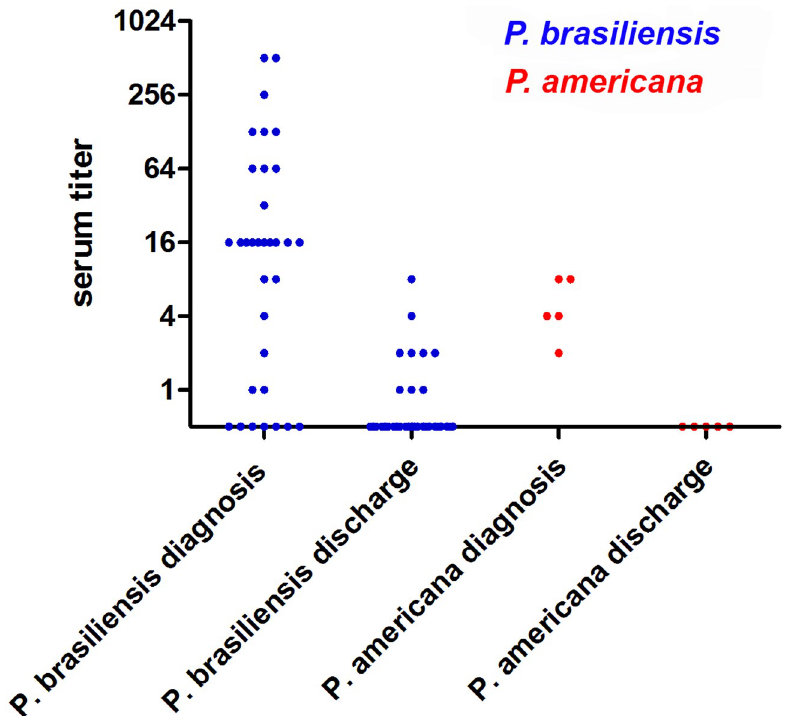
Fig 4. Immunodiffusion reactivity in serological samples from 38 patients of this study. Serum antibody titers from patients infected with P . brasiliensis (blue dots) and P . americana (red dots) are